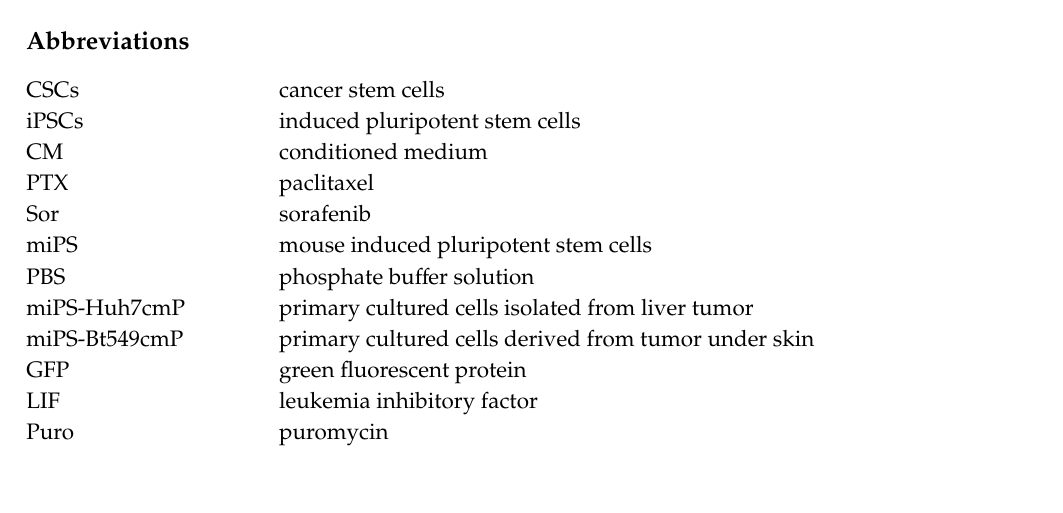
Figure S1: Representative images showed the e ff ect of combined treatment of PTX and Sor on Huh7cells, Table S1: Showing the antiangiogenic e ff ect of single or combined treatment of Ptx and / or Sor on miPS-Huh7cmP cells in the chick CAM, Table S2: Showing the antiangiogenic e ff ect of single or combined treatment of Ptx and / or Sor on miPS-BT549cmP cells in the chick